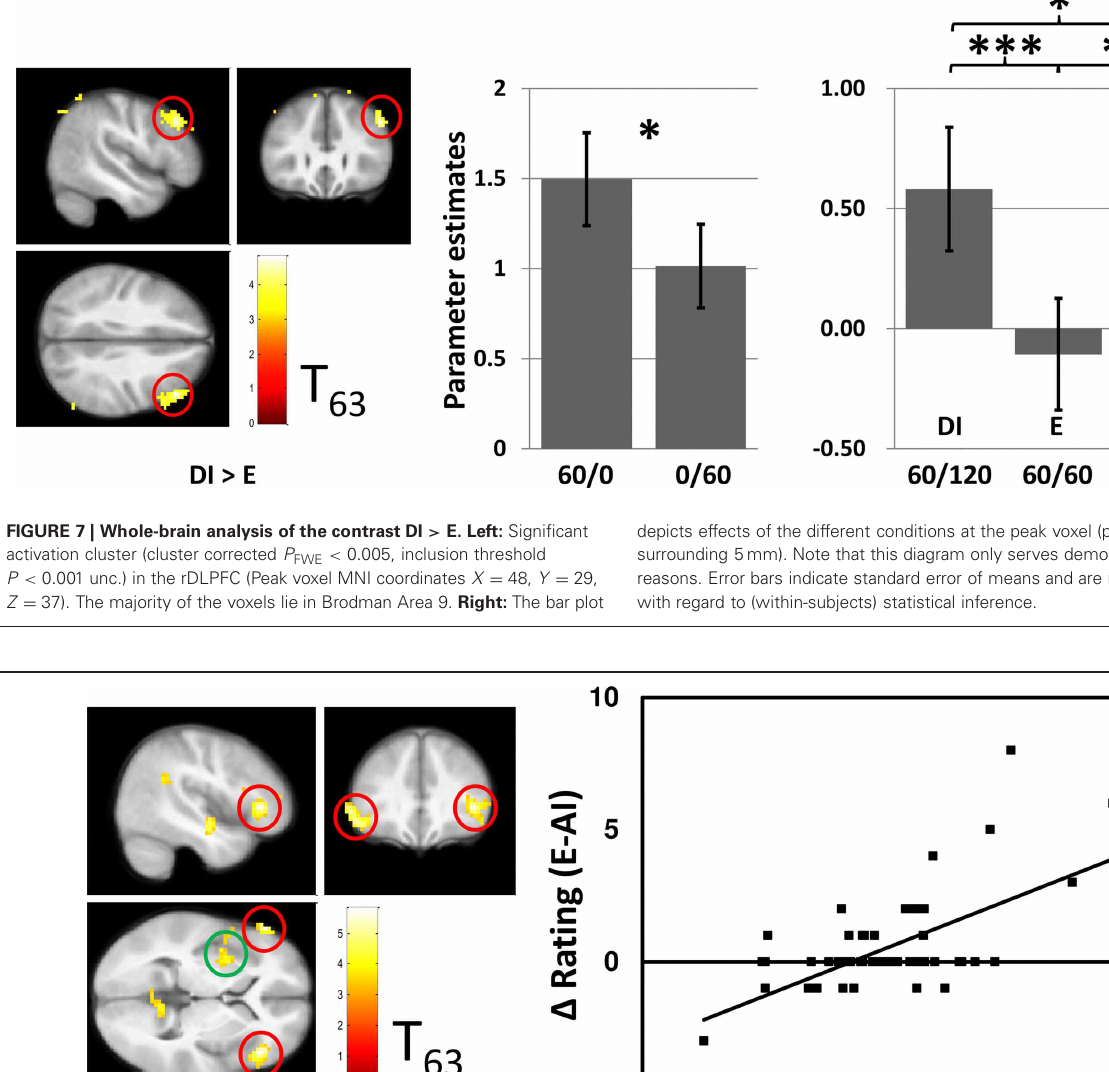
Y = 32, Z = 1, and X = − 57, Y = 35, Z = 1) and in the left insula ( X = − 33, Y = 2, Z = − 2). Right: The scatterplot depicts the relation between contrast and ratings for the peak voxels averaged across both sides of the VLMPFC clusters, and serves demonstration reasons